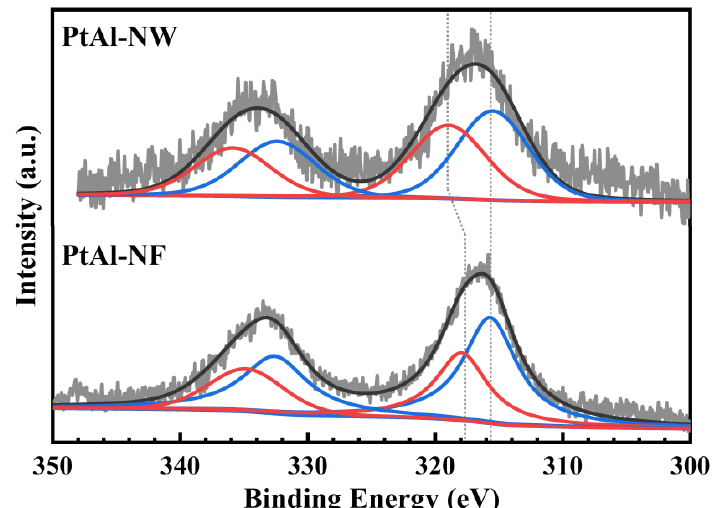
Figure 9. XPS Pt 4d spectra of PtAl-NF and PtAl-NW.